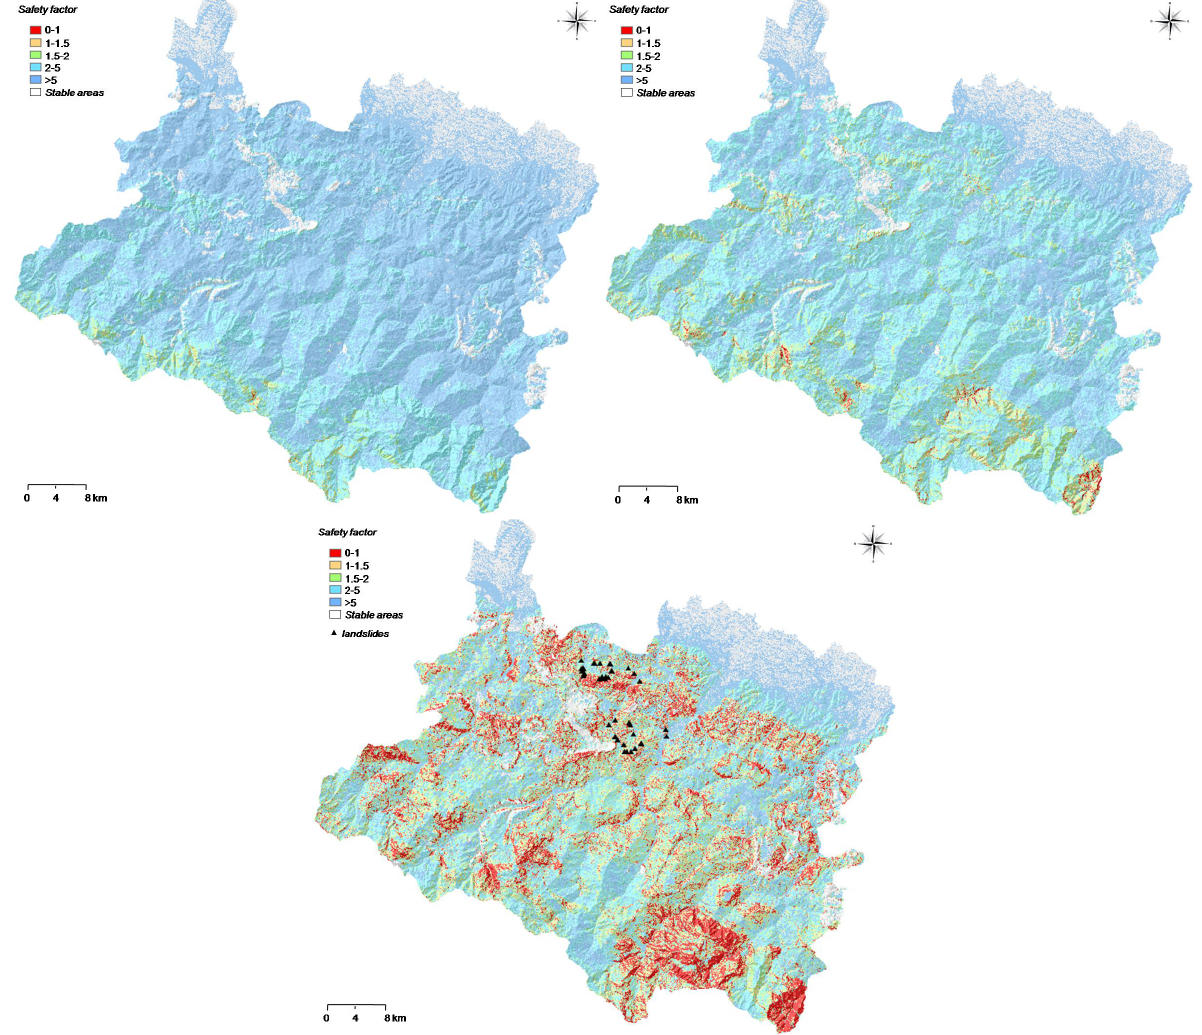
Figure 13c Fig. 13. SLIP analysis on the study area: time-varying maps of F s corresponding to the events occurred in April 2005 (14% of unstable